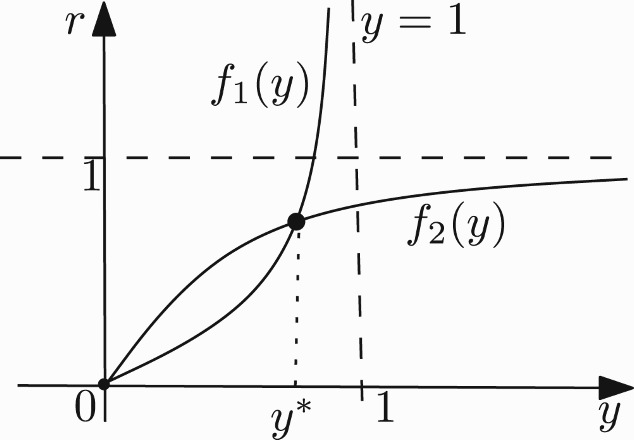
Graph of the functions f
1 and f
2 in the case a>1/k.